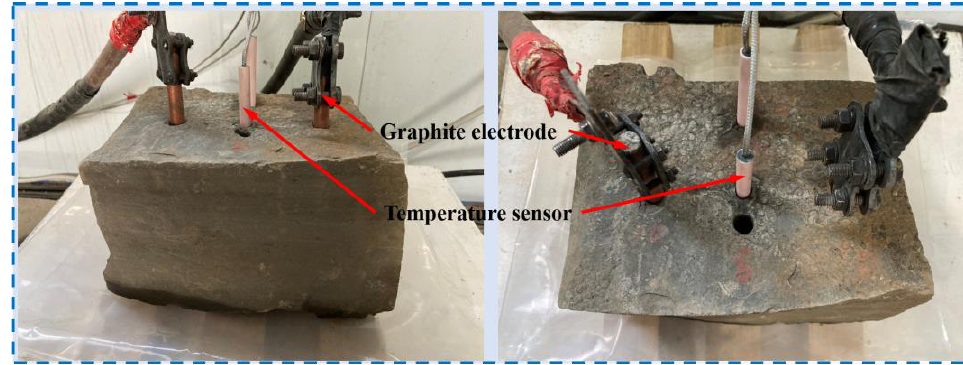
Figure 4. Arrangement of the electrodes and the temperature sensors in an oil shale sample.